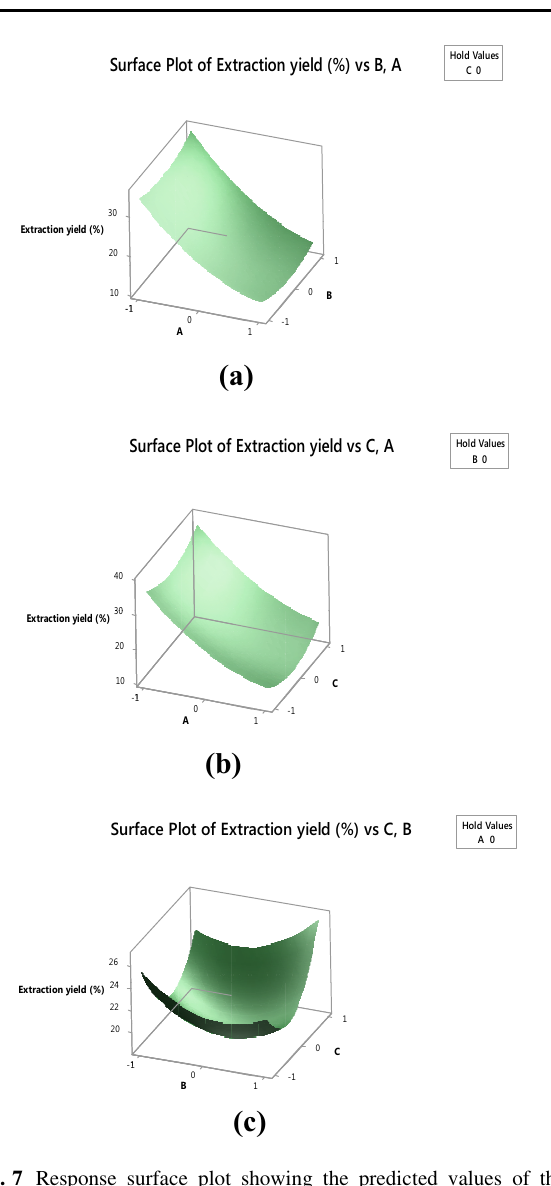
Fig. 7 Response surface plot showing the predicted values of the extraction yield with effect on particle size (A) and % co-solvent in solvent (B) ( a ), particle size with coal/total amount of co-sol- vent ? solvent (C) ( b ) and % co-solvent in solvent (B) and coal/total amount of co-solvent ? solvent (C) ( c ) [A: amount of co-solvent (EDA), A ? B: total amount of co-solvent ? solvent (EDA ? NMP)]